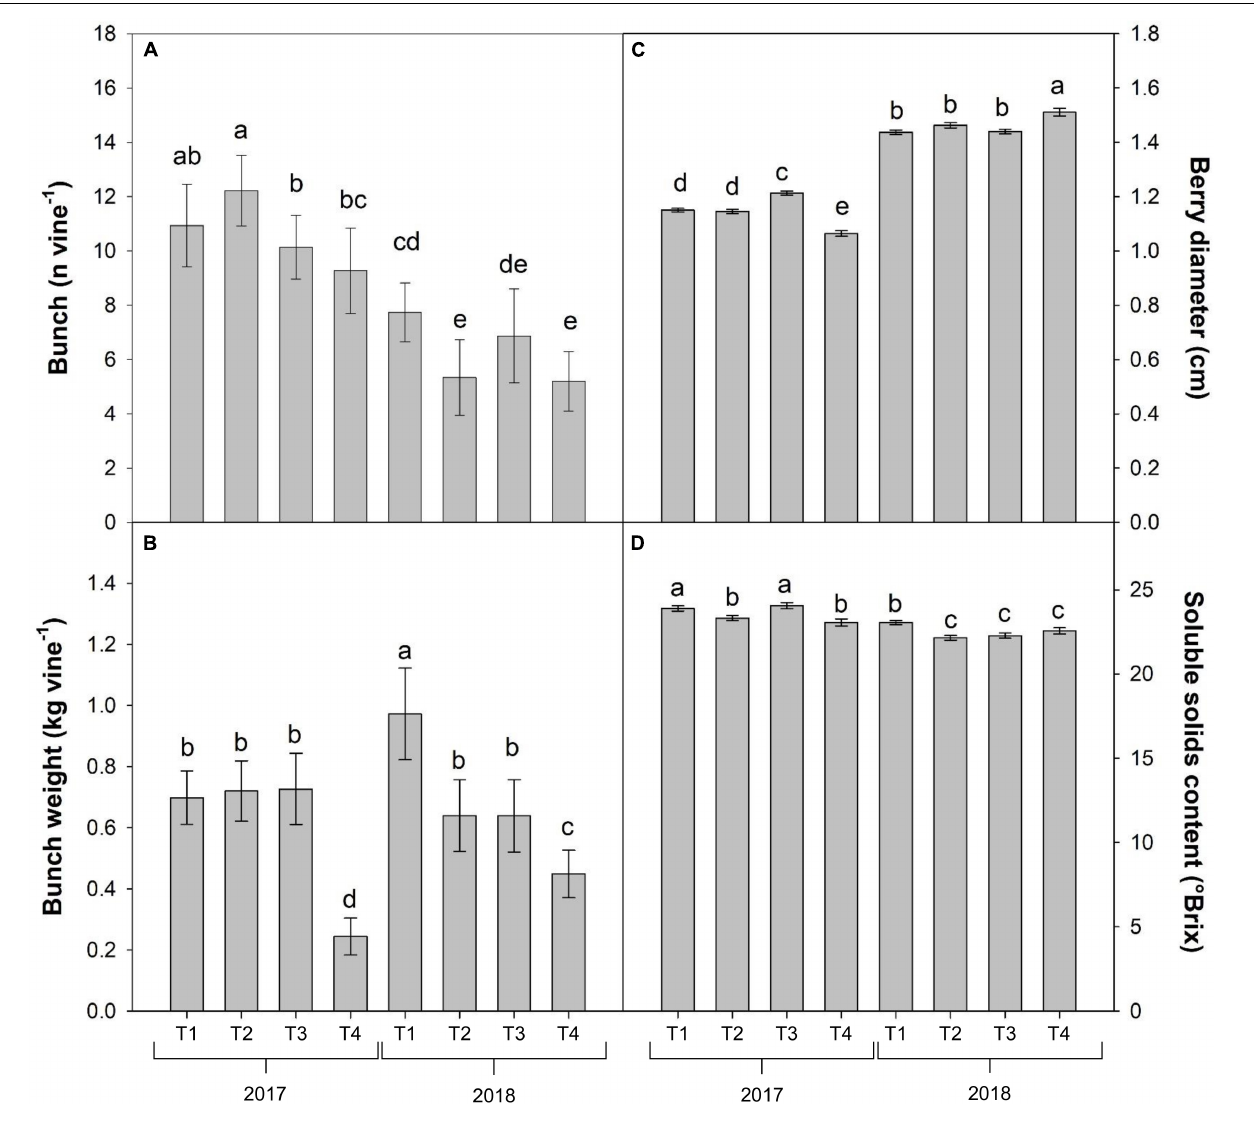
FIGURE 3 | Combined effects of year and foliar treatments on bunches number (A) and weight (B) per vine and berry diameter (C) and soluble solids content (D) in V. vinifera “Aglianico” vines (mean ± SE). Different letters indicate significant differences according to Duncan’s multiple-range test ( P ≤ 0.05). [T1 – only industry water mixture of copper oxychloride; T2 – industry water mixture of copper oxychloride plus Trym R (cid:13) ; T3 – half dose of copper oxychloride water mixture; T4 – half dose of copper oxychloride water mixture plus Trym R (cid:13)